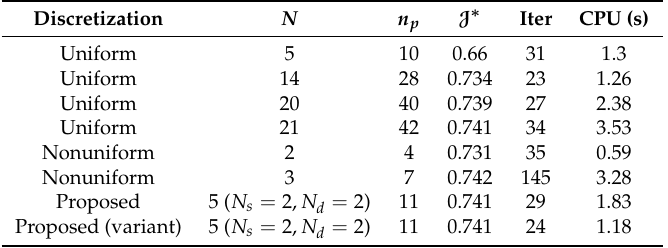
Table 6. Optimal objective values, number of iterations, and CPU times for different discretization strategies in Problem (44). n p denotes the total number of optimization variables for each strategy.